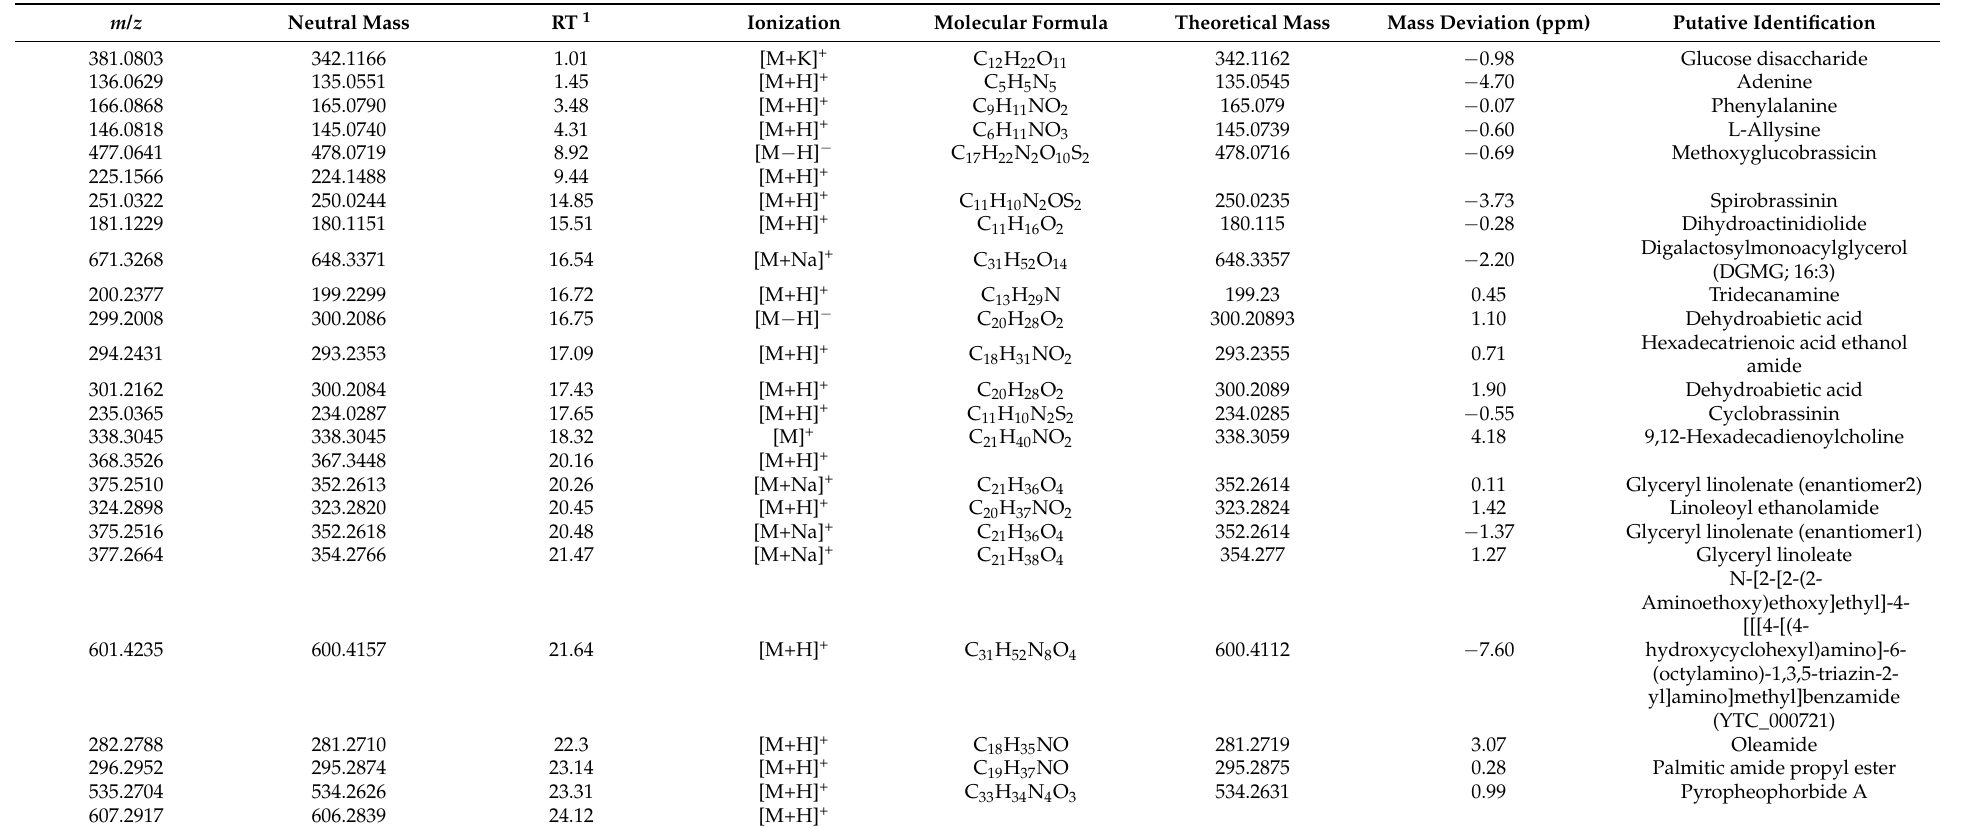
Table 1. Putative identification of metabolites identified in a multivariant supervised analysis (PLS-DA) with a VIP-score > 2 specifically under cold (12 ◦ C)